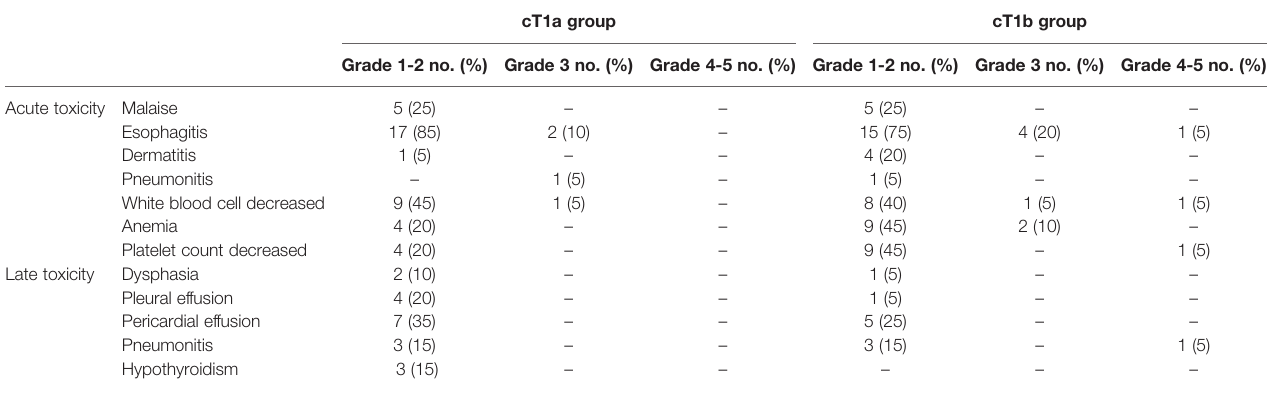
TABLE 2 | Treatment toxicities.